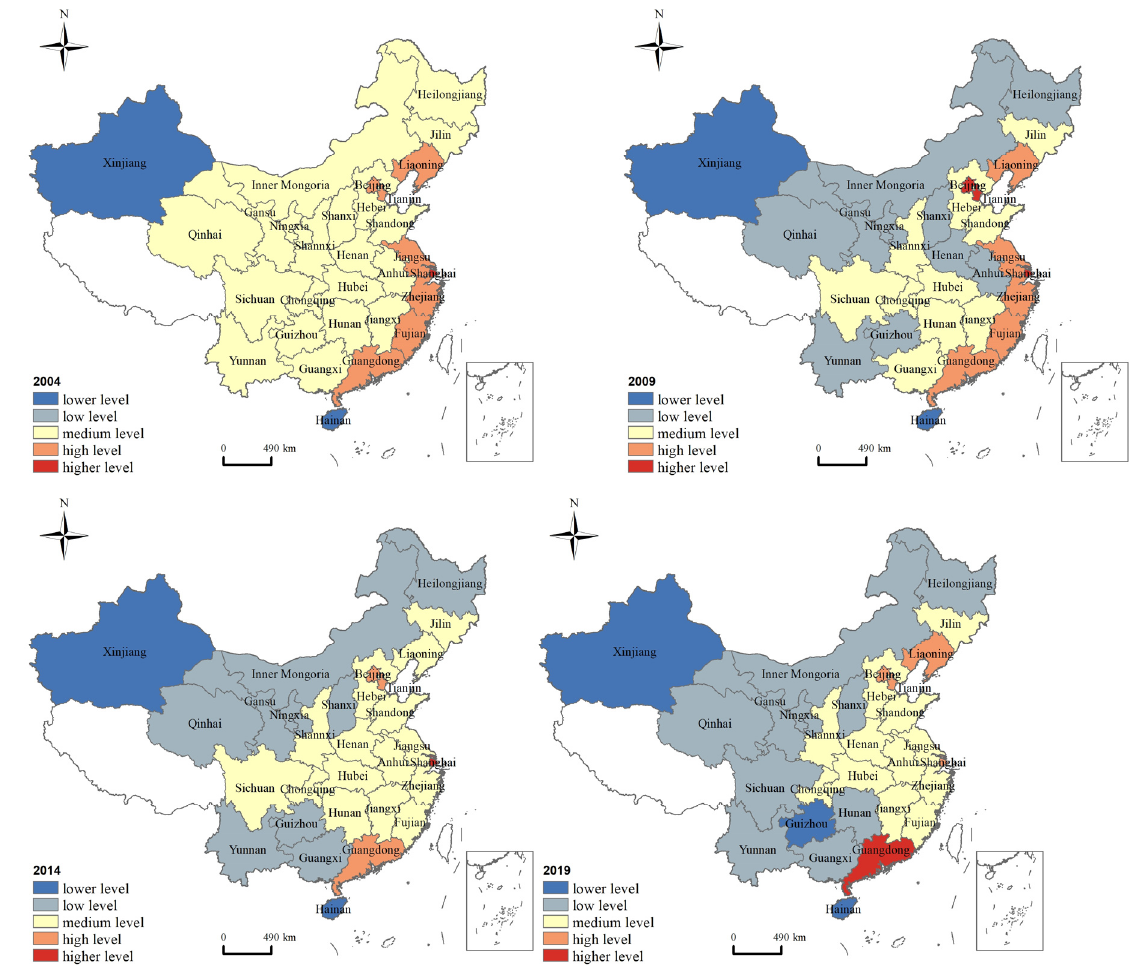
Figure 2. Spatio-temporal differences of co-agglomeration index between the manufacturing and producer